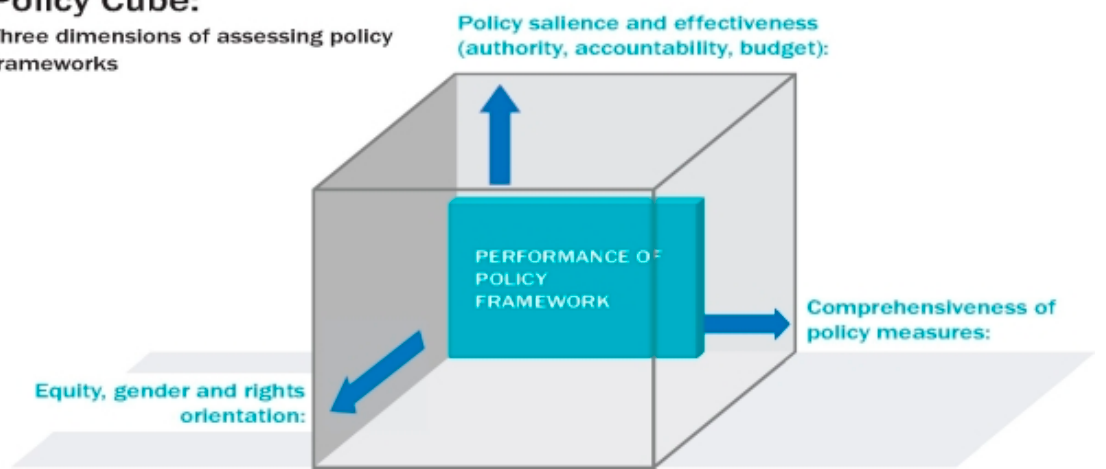
Figure 1. Three dimensions to assess the robustness of diet-related NCD frameworks: the policy cube approach. Reprinted from Buse et al.